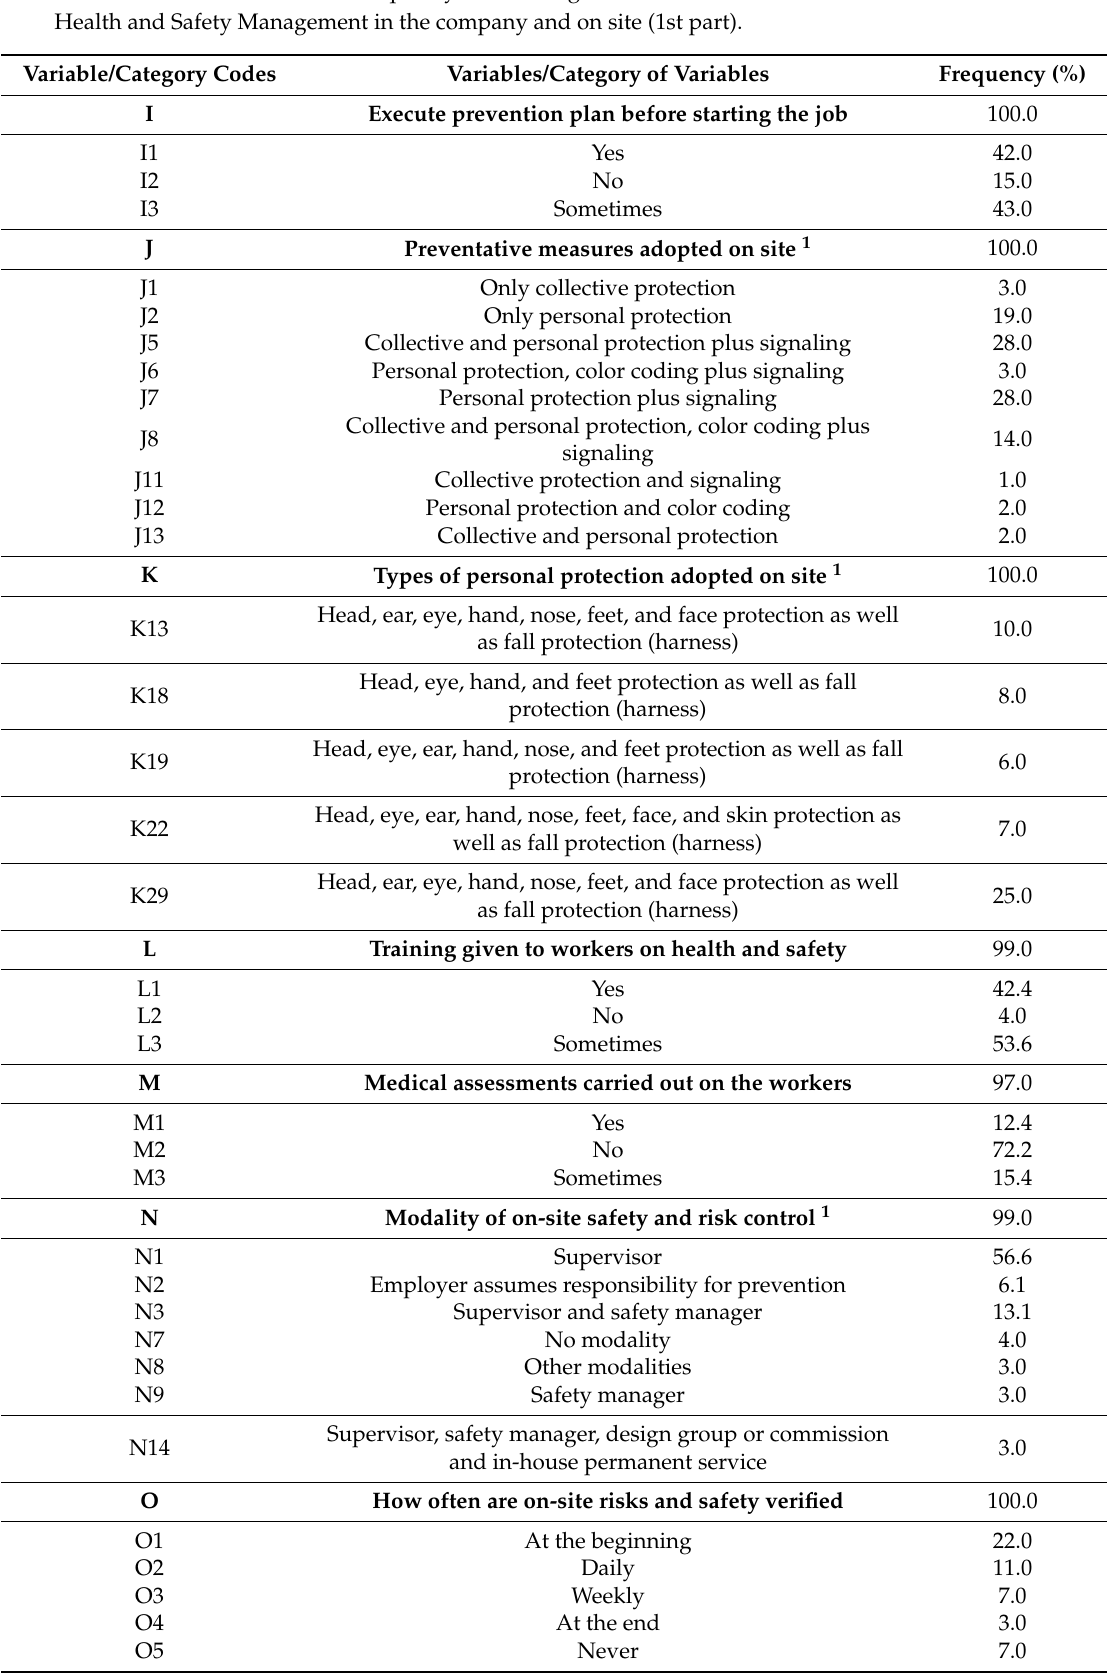
Table A2. Nomenclature and frequency of the categories of variables for Prevention Activities and Health and Safety Management in the company and on site (1st